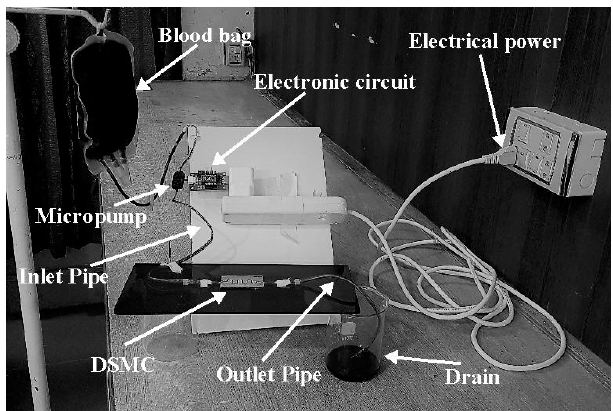
Figure 8. Experimental test setup.